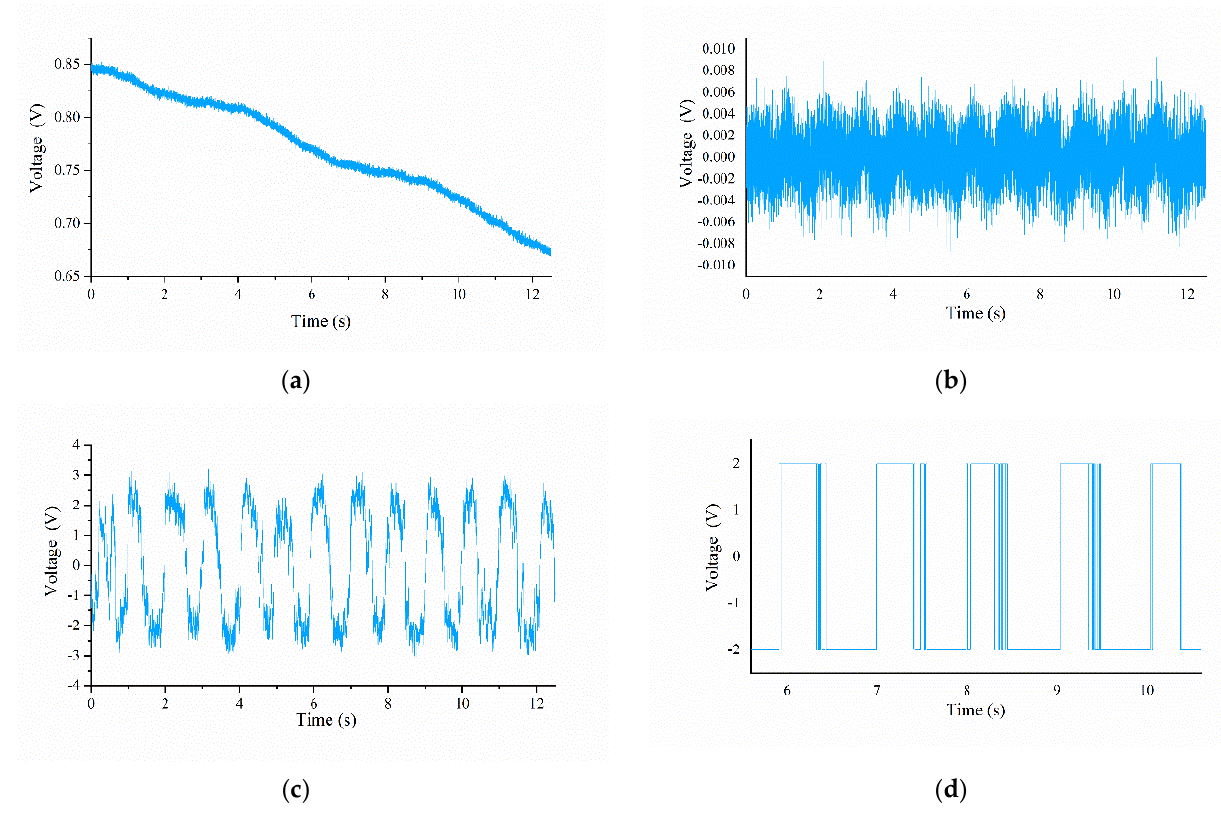
Figure 7. Diagram of tactile signal processing flow: ( a ) diagram of row output signal; ( b ) original signal processed by de-baseline method; ( c ) signal processed by SR model; ( d ) signal segment passed through software-designed threshold comparator.